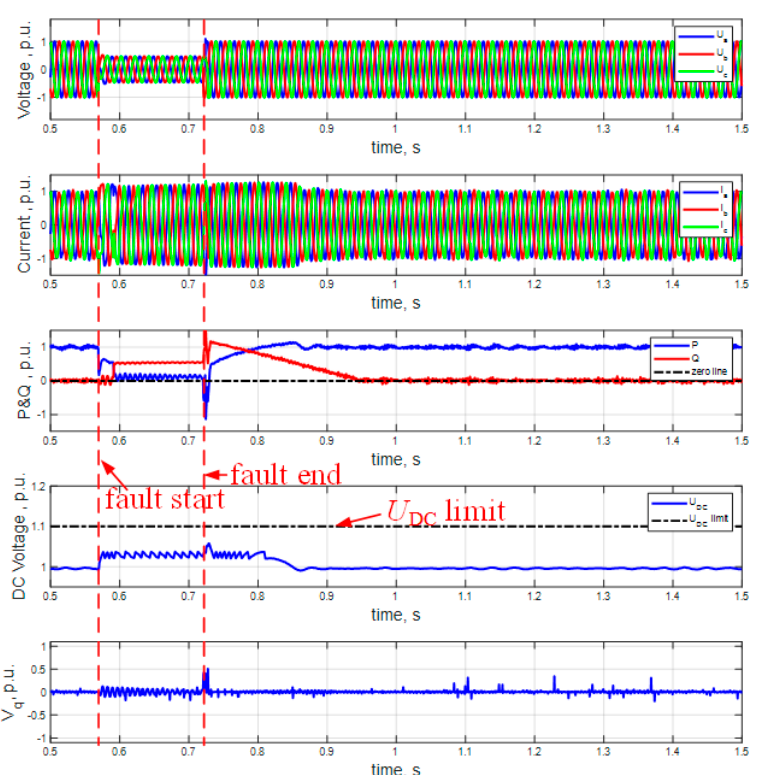
Figure 14. With reactive current injection, a reduction rate of I ∗ q = 80 p.u./s, the faster reactive current exit rate caused a short-term reversal of active power (P curve below the black dashed line). Therefore, the DC voltage quickly returned to its nominal value after a fault.